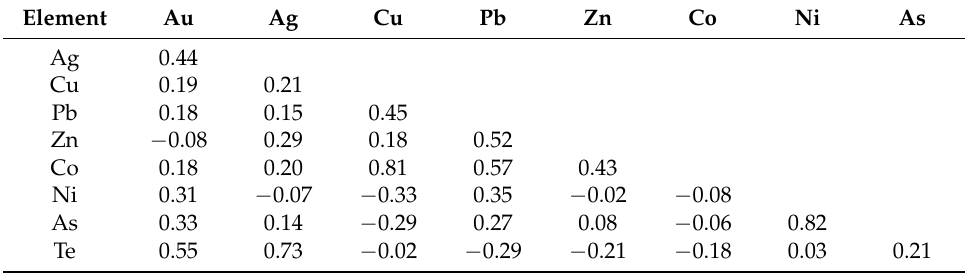
Table 2. Correlation coefficients between trace elements in Py1 from the Huanxiangwa gold deposits.